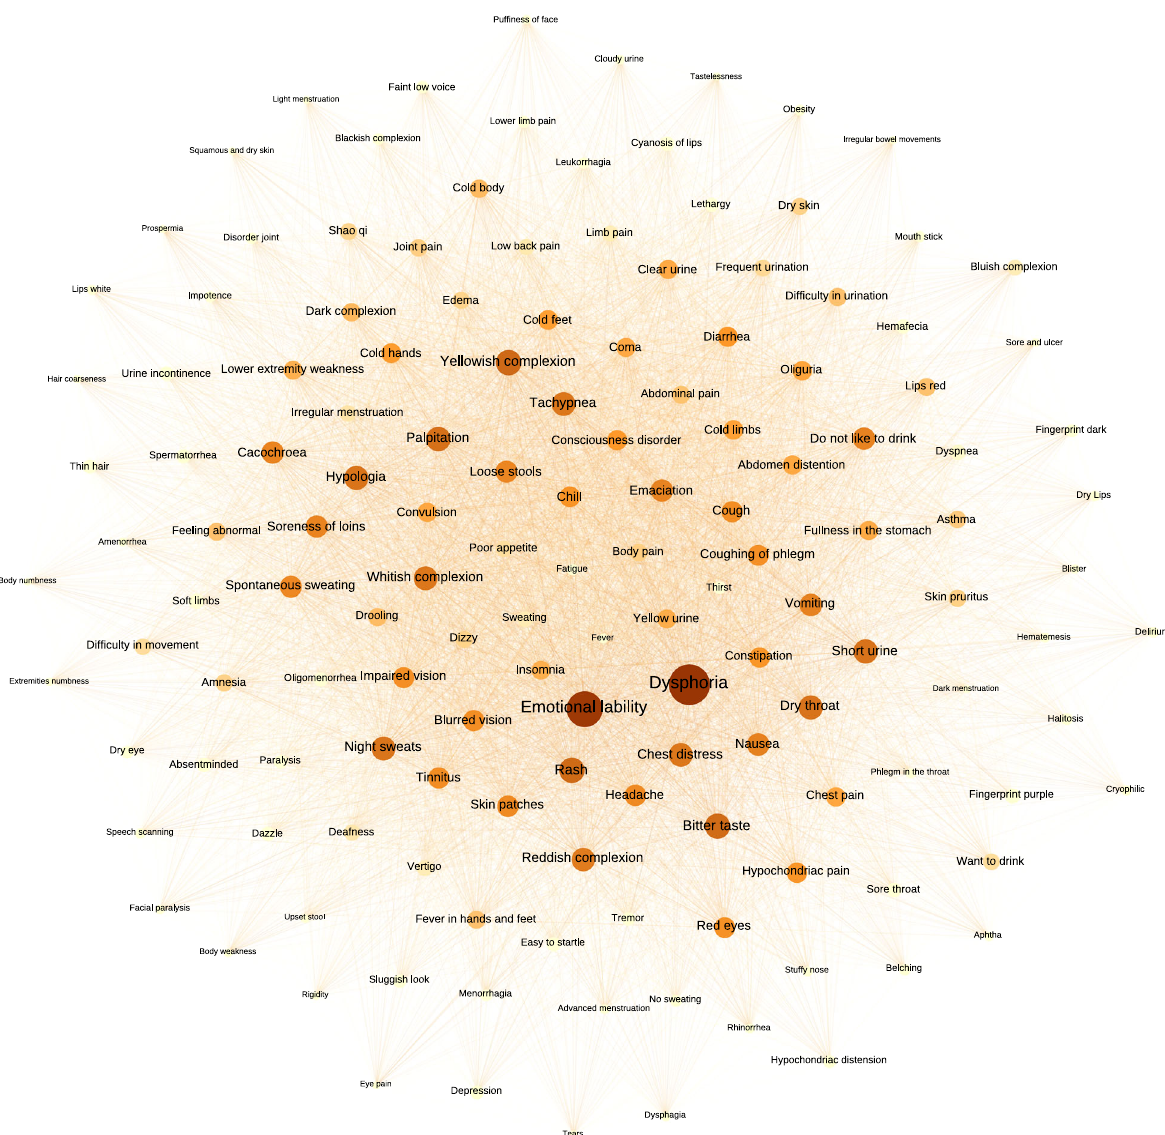
Fig. 3 Construction of symptom clinical association network(SCN). The nodes indicate the symptoms and interconnecting edges in SCN represent the clinical co-occurrence. Node size and color re fl ected the diversity of symptom phenotypes in SCN (a high diversity is represented by large size node and deep orange color node). Here, fi ltering the node and related edges of symptom phenotypic diversity value <60 in the network and remaining 144 nodes and 6894 edges are